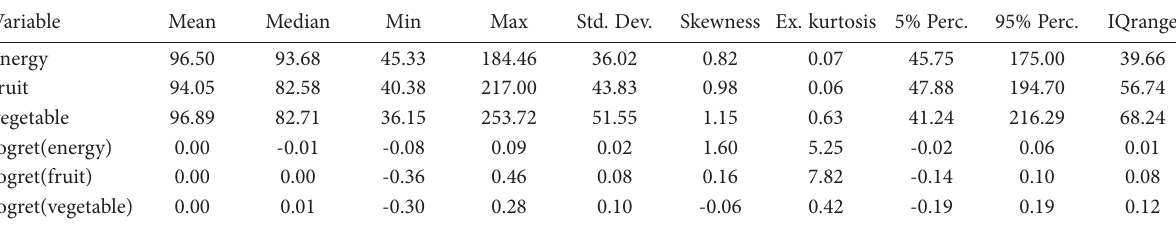
Table A1. Summary Statistics.